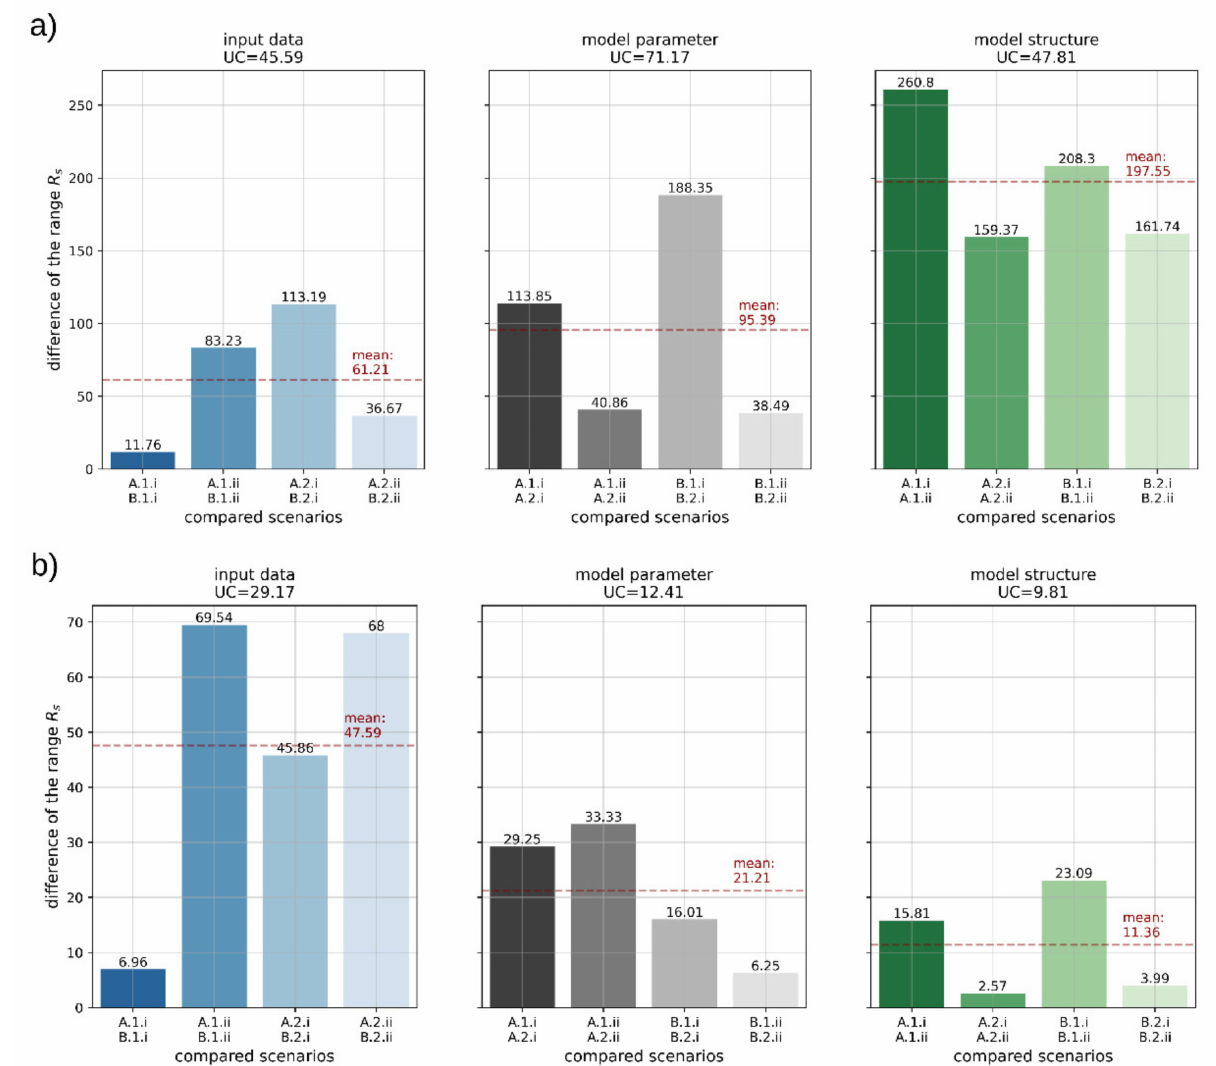
Figure 10. Identification of the most impact uncertainty source with the standard deviation UC of the four scenarios comparisons for each uncertainty source (input data, model parameter, model structure) and the two analyzed model variables flow ( a ) and water depth ( b